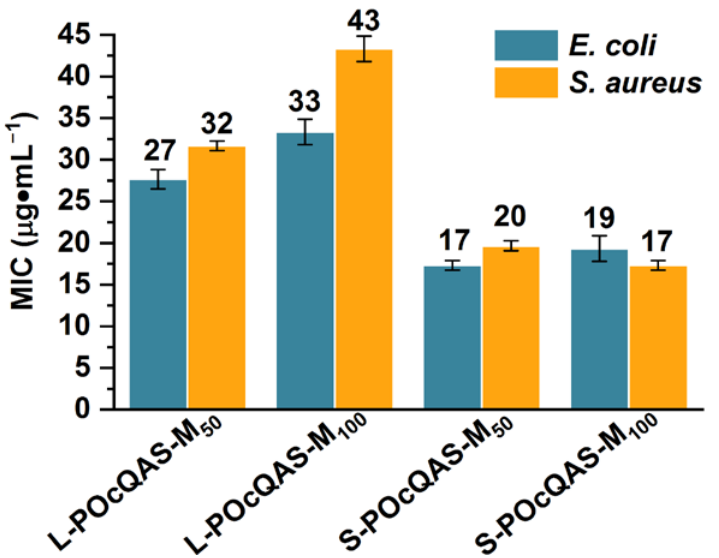
Figure 6. Minimum inhibitory concentrations (MICs) (µg/mL) of synthesized L-POcQASs and S-POcQASs against S. aureus and E. coli .